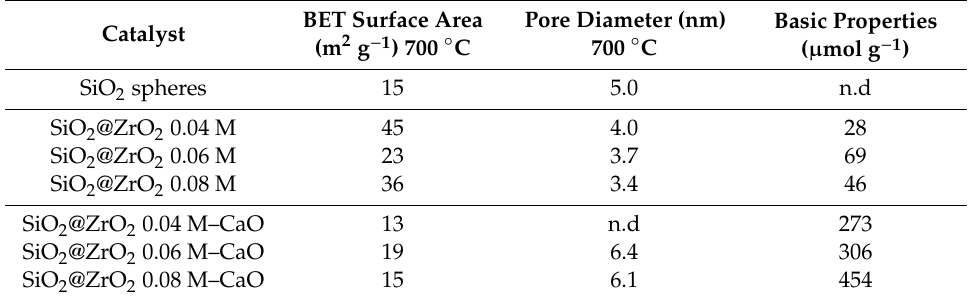
Table 1. Surface area, pore diameter, and basicity for SiO 2 ZrO 2 and SiO 2 @ZrO 2 –CaO. Bet = Brunauer–Emmett–Teller.